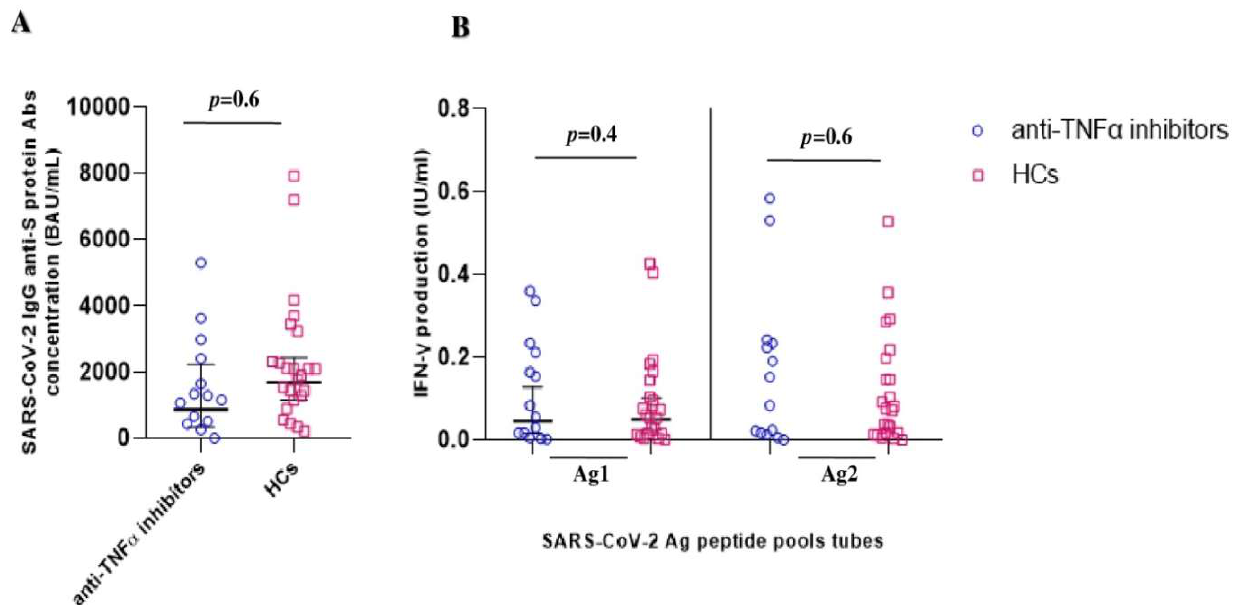
Figure 2. SARS-CoV-2 vaccine-elicited adaptive immune response after booster shot in IBD patients on anti-TNFα treatments and healthy controls (HCs). ( A ) Anti-SARS-CoV-2 trimeric S protein antibody concentration (BAU/mL) response between the IBD patients on anti-TNFα treatments (blue circles) and HCs (violet squares) groups. ( B ) QuantiFERON SARS-CoV-2 antigen tubes (Ag1 and Ag2) response, expressed as IFNγ production (IU/mL), among the IBD patients (blue circles) and HCs (violet squares) groups.